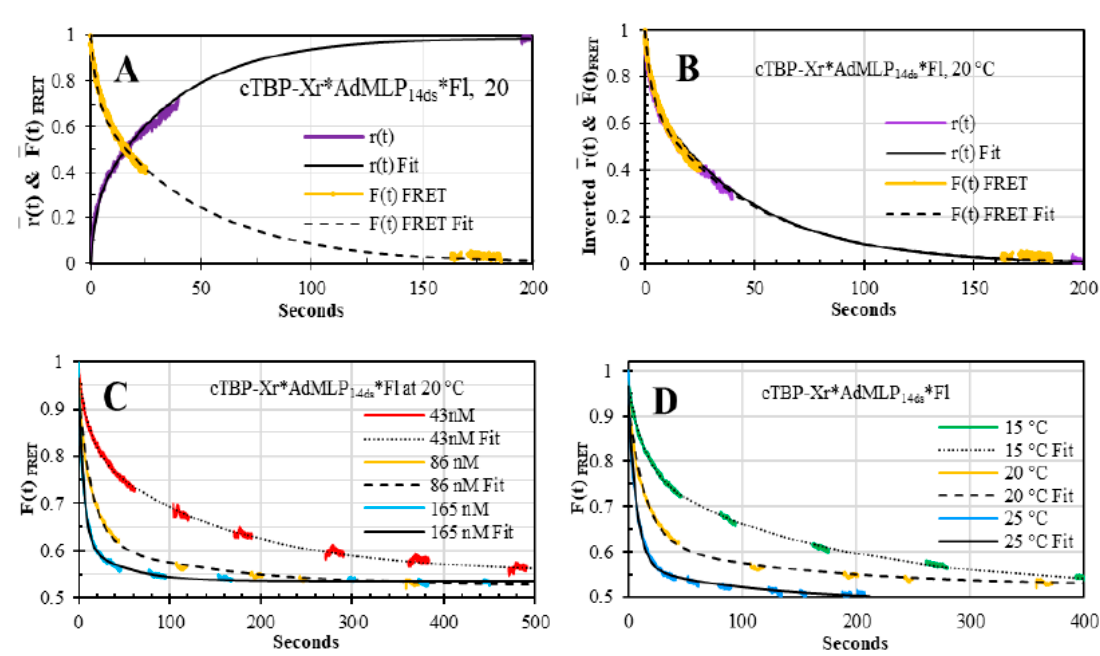
Figure 10. Core TBP-AdMLP 14ds association kinetics. ( A , B ) The association kinetics of cTBP (260 nM)-Xr*AdMLP 14ds (60 nM) and cTBP (86 nM)-Xr*AdMLP 14ds *Fl (20 nM) were monitored by r ( t ) (orange) and F ( t ) FRET (purple) sensing modalities, at 20 ◦ C. The r ( t) and F ( t ) FRET fits yielded eigenvalues of 0.350 ( ± 0.040) s − 1 and 0.337 ( ± 0.078) s − 1 , which resulted in k on values of 1.35 ( ± 0.05) × 10 6 M − 1 s − 1 and 1.30 ( ± 0.10) × 10 6 M − 1 s − 1 , respectively. Both k on values are in excellent agreement since the protein / probe ratio is 4.3 and they are in the error range of the reported k + 1 of 1.26 ( ± 0.05) × 10 6 M − 1 s − 1 , at 25 ◦ C [2]. ( C ) The concentration dependence of the cTBP-AdMLP 14ds complex was observed by the F ( t ) FRET sensing modality with cTBP at 43 nM (red), 86 nM (orange), and 165 nM (blue) concentrations, at 20 ◦ C, reacting with 20 nM Xr*AdMLP 14ds *Fl. ( D ) The temperature dependence was also monitored by the F ( t ) FRET traces, at 15 ◦ C (green), 20 ◦ C (orange), and 25 ◦ C (blue) of 86 nM cTBP reacting with 20 nM Xr*AdMLP 14ds *Fl. The FRET global fits (black lines) of the concentration and temperature dependence traces yielded a two-intermediate reaction mechanism with k + 1 values of 9.62 ( ± 0.41) × 10 5 M − 1 s − 1 , 1.26 ( ± 0.05) × 10 6 M − 1 s − 1 and 1.64 ( ± 0.06) × 10 6 M − 1 s − 1 at 15 ◦ C, 20 ◦ C and 25 ◦ C, respectively